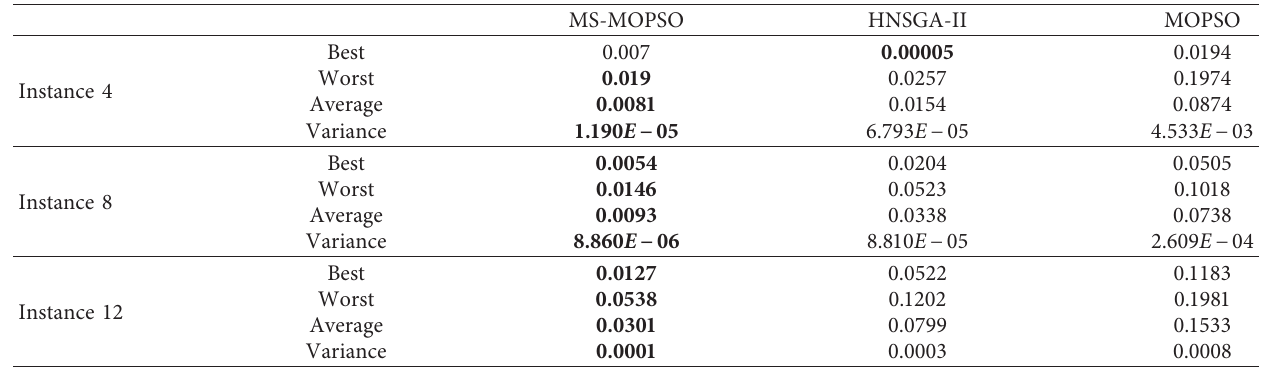
Table 6: Results of IGD for three